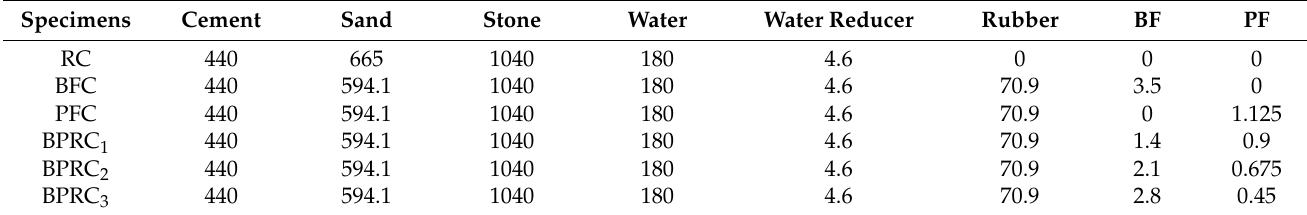
Table 2. Mixing ratio (Unit: kg/m 3 ).